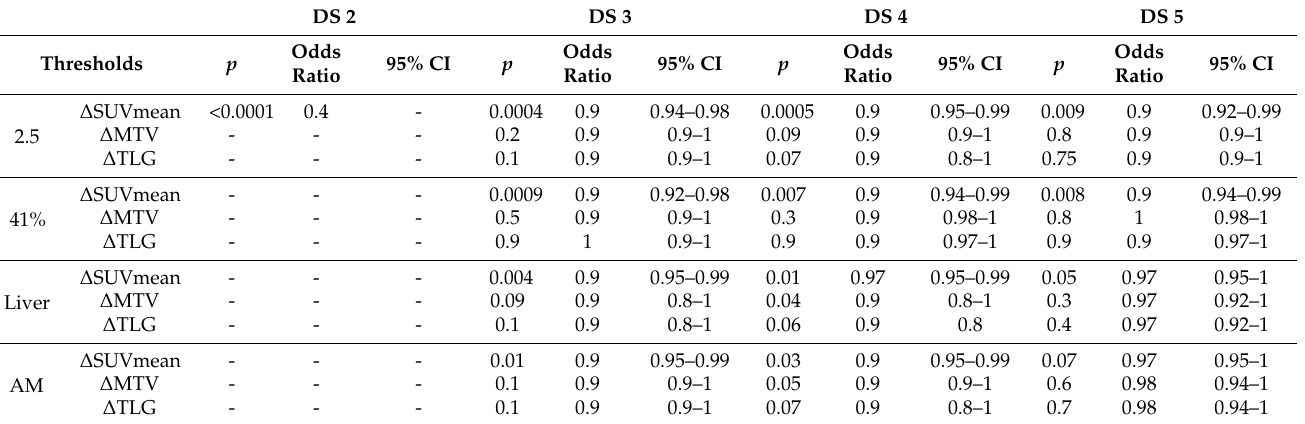
Table 5. Logistic regression of different delta threshold values with respect to